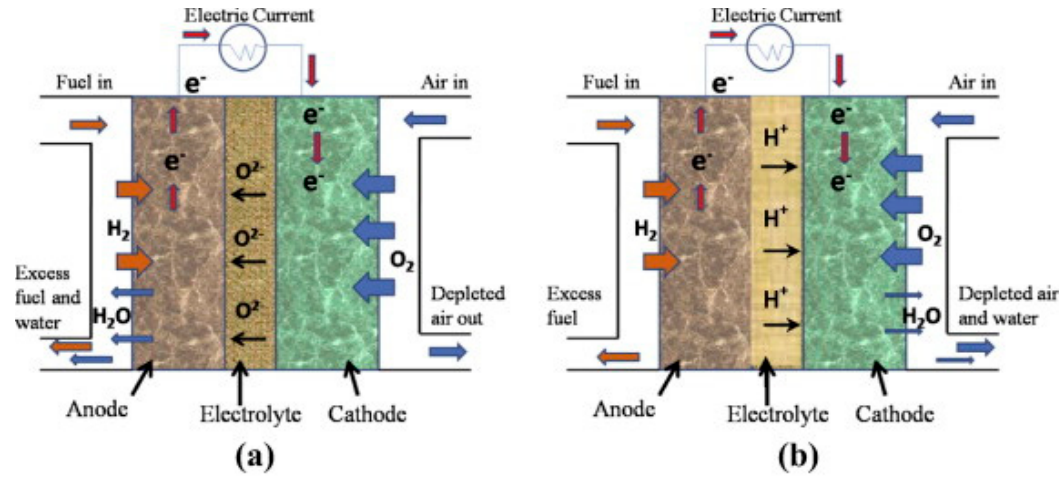
Figure 11. Schematic representation of solid oxide fuel cell (SOFC) ( a ) oxide-ion conducting electrolyte, ( b ) proton conducting electrolyte [136].